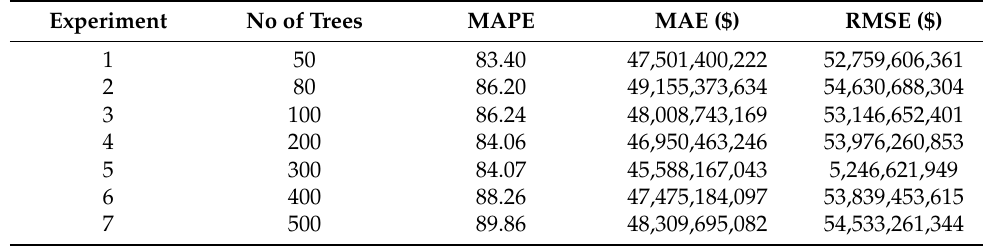
Table 5. Revenue loss prediction error of different experiments for the heavy wind